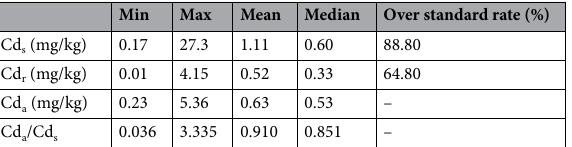
Table 1. The monitoring results of soil cadmium, activated cadmium, and rice